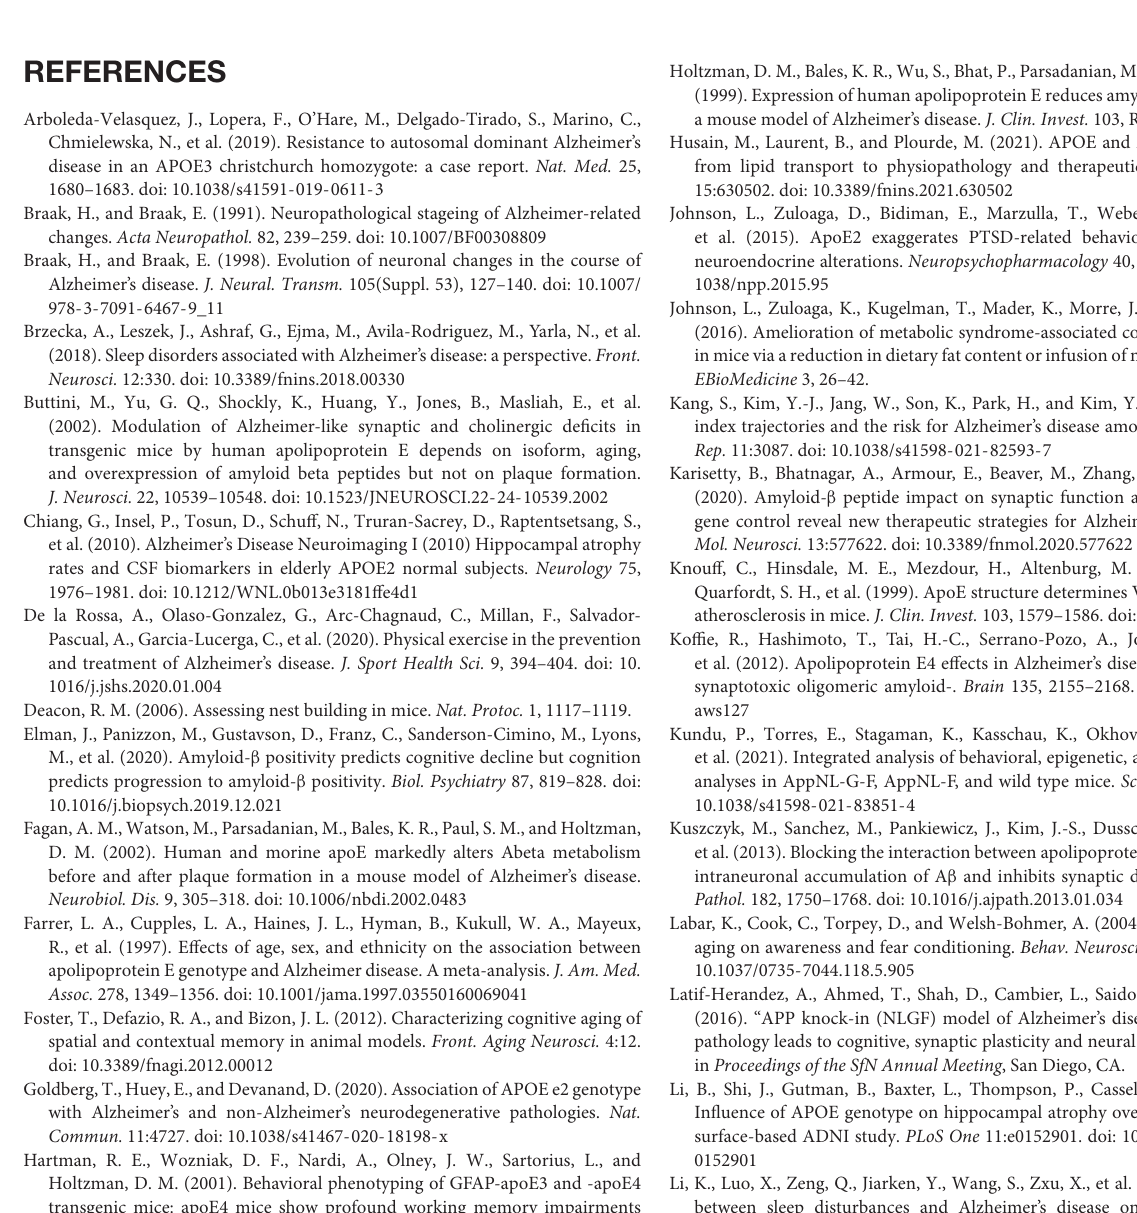
Supplementary Figure 4 | Performance of NL-G-F, NL-F, and WT males (A,C,E) and females (B,D,F) at the 18-month time point. (A) There was an effect of APP on baseline motion of the males. NL-F males moved more during the baseline period than NL-G-F and WT males. ∗ p < 0.05. (B) Activity levels of NL-G-F, NL-F, and WT females during the baseline period. (C) There was an effect of APP on contextual fear memory of males. NL-G-F males froze less than NL-F and WT males during the contextual fear memory test. o p < 0.05. (D) There was an effect of APP on contextual fear memory of females. NL-G-F females also froze less than NL-F and WT females during the contextual fear memory test. o p < 0.05. (E) There was an effect of APP on cued fear memory of males. NL-G-F males froze less during the tone than NL-F and WT males. o p < 0.05. (F) There was an effect of APP on cued fear memory of females. NL-G-F females froze less during the tone than NL-F females. ˆ p <